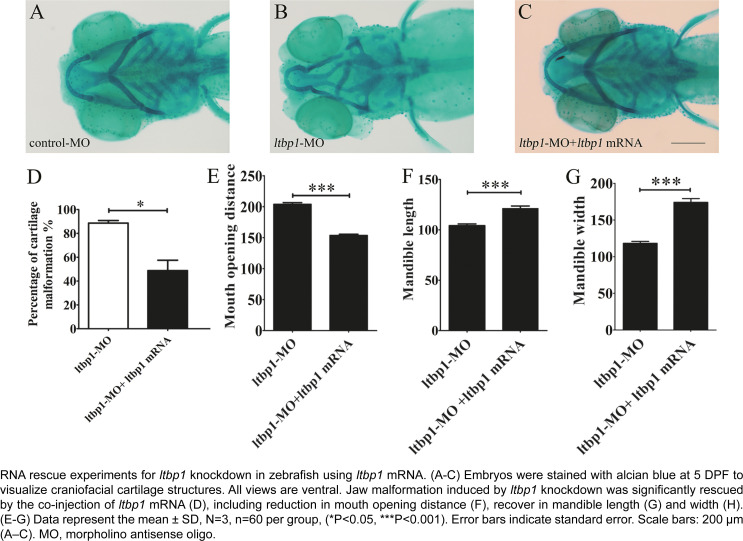
Specificity of ltbp1 knockdown phenotype